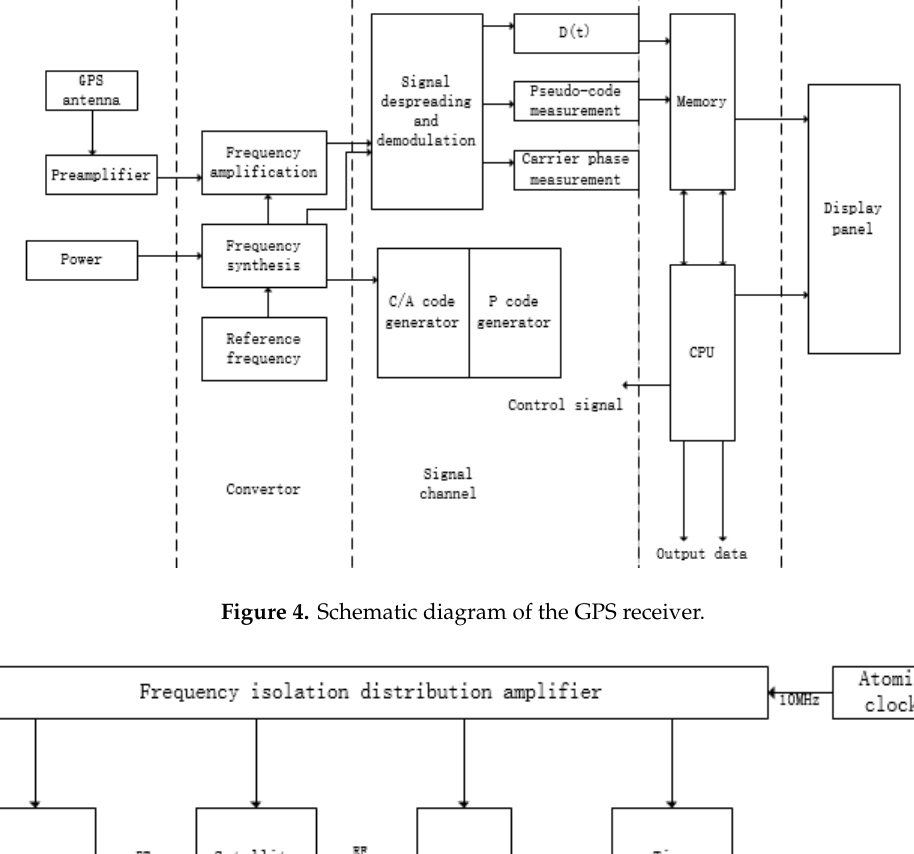
Figure 4. Schematic diagram of the GPS receiver.